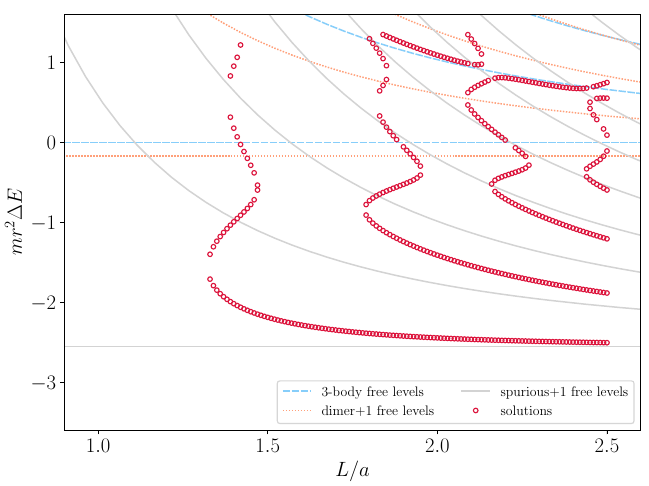
Figure 2 . The solutions of the three-body quantization condition in the presence of the spurious pole. One observes the unphysical merging and disappearance of energy levels that never occurs in a consistent